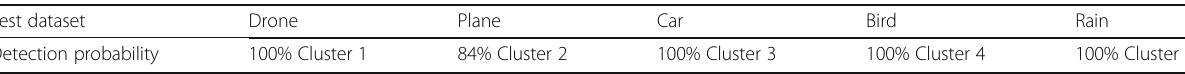
Table 2 Experimental results for sound recognition without noise Test